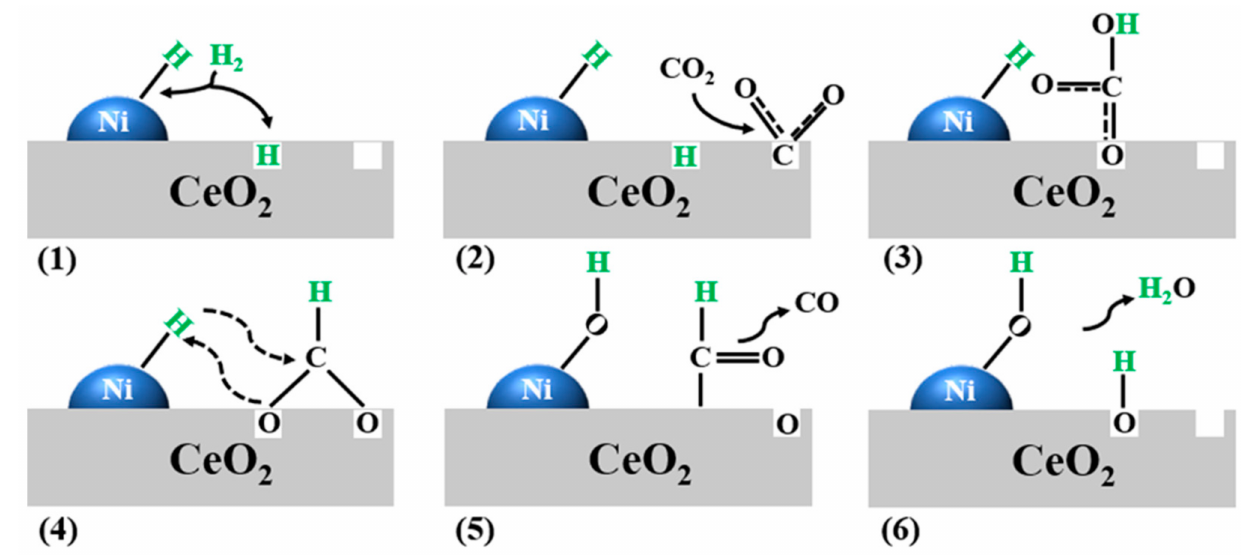
Figure 7. The proposed reaction mechanism of the RWGS reaction over Ni-CeO 2 catalyst. Deng et al. synthesized 10Ga5Cu-CeO 2 catalyst using direct pyrolysis for pho-